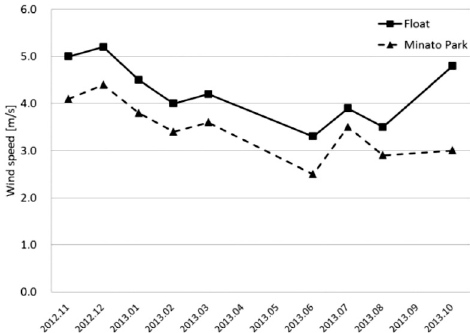
Fig. 7. Monthly average wind speed comparison between the offshore platform and Minato Park.